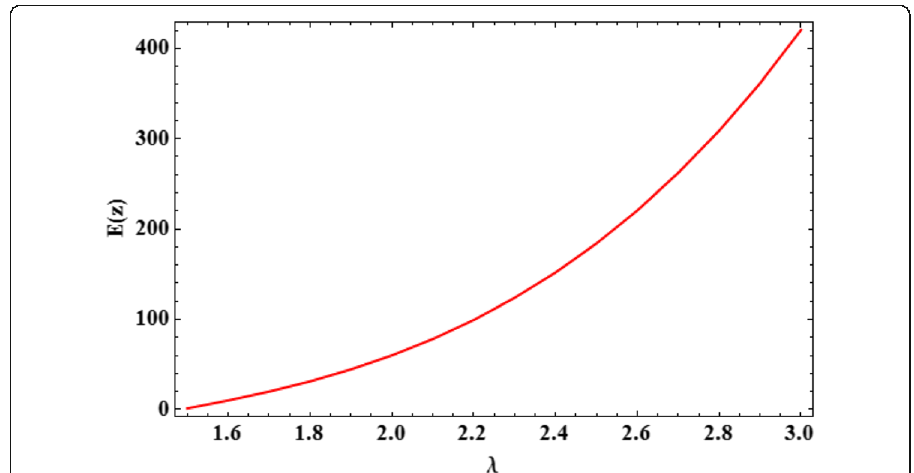
Fig. 2 The expected buffer content E ( z ) against